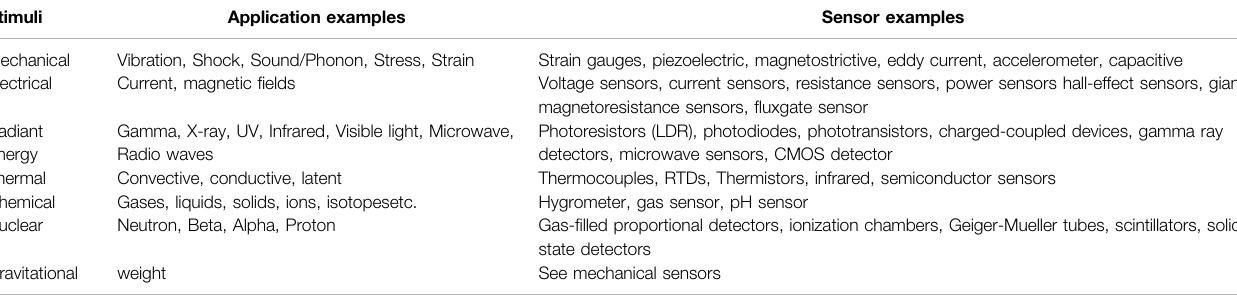
TABLE 1 | Example of energy forms that drive changes in material state and the transducers employed to observe the corresponding exposure history.